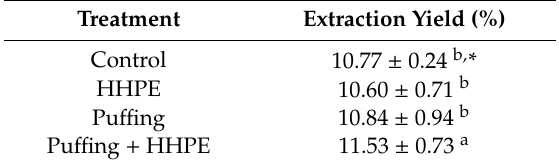
Table 3. E ff ect of the combination of pu ffi ng and HHPE on extraction yield of turmeric. Treatment Table 3. Effect of the combination of puffing and HHPE on extraction yield of turmeric. Treatment